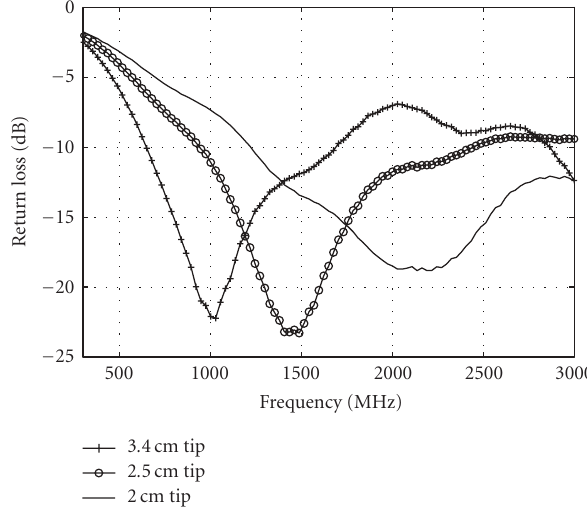
Figure 5: Plot of wavelength versus frequency for the 90% and 40% glycerin solutions along with the TE 10 cuto ff wavelengths for the receiving waveguides.